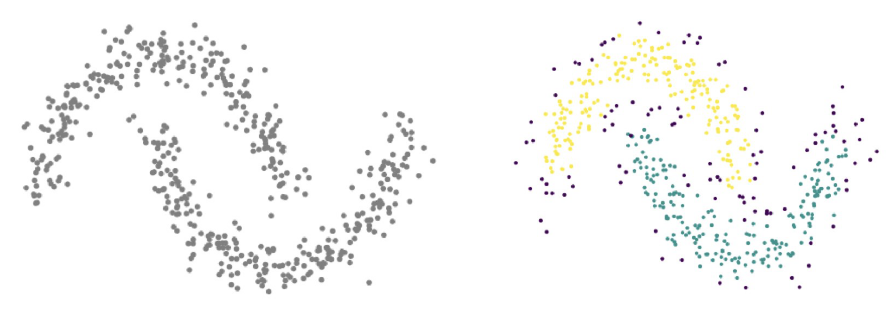
Figure 4. HDBSCAN performance ( right ) on double crescent shaped clusters ( left ) in R 2